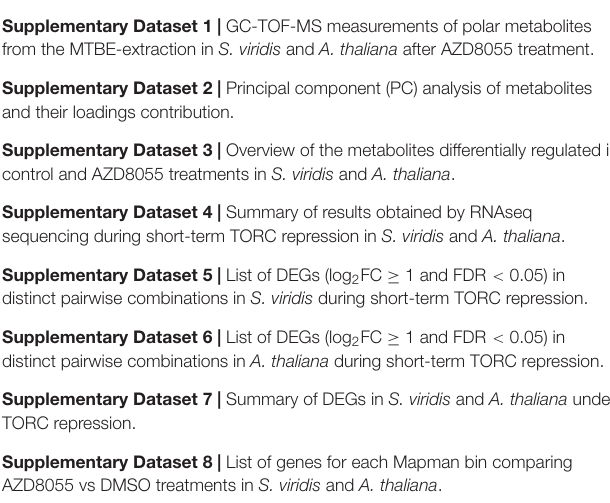
Supplementary Table 2 | Protein IDs of FKBP12 used for sequence